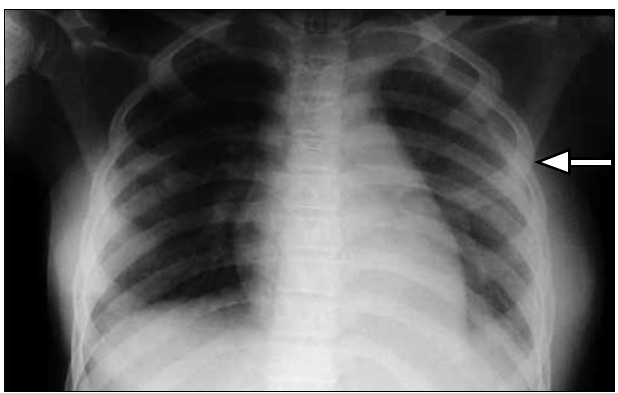
Fig. 1. Supine chest radiograph of the patient, with a large pleural effusion on the left